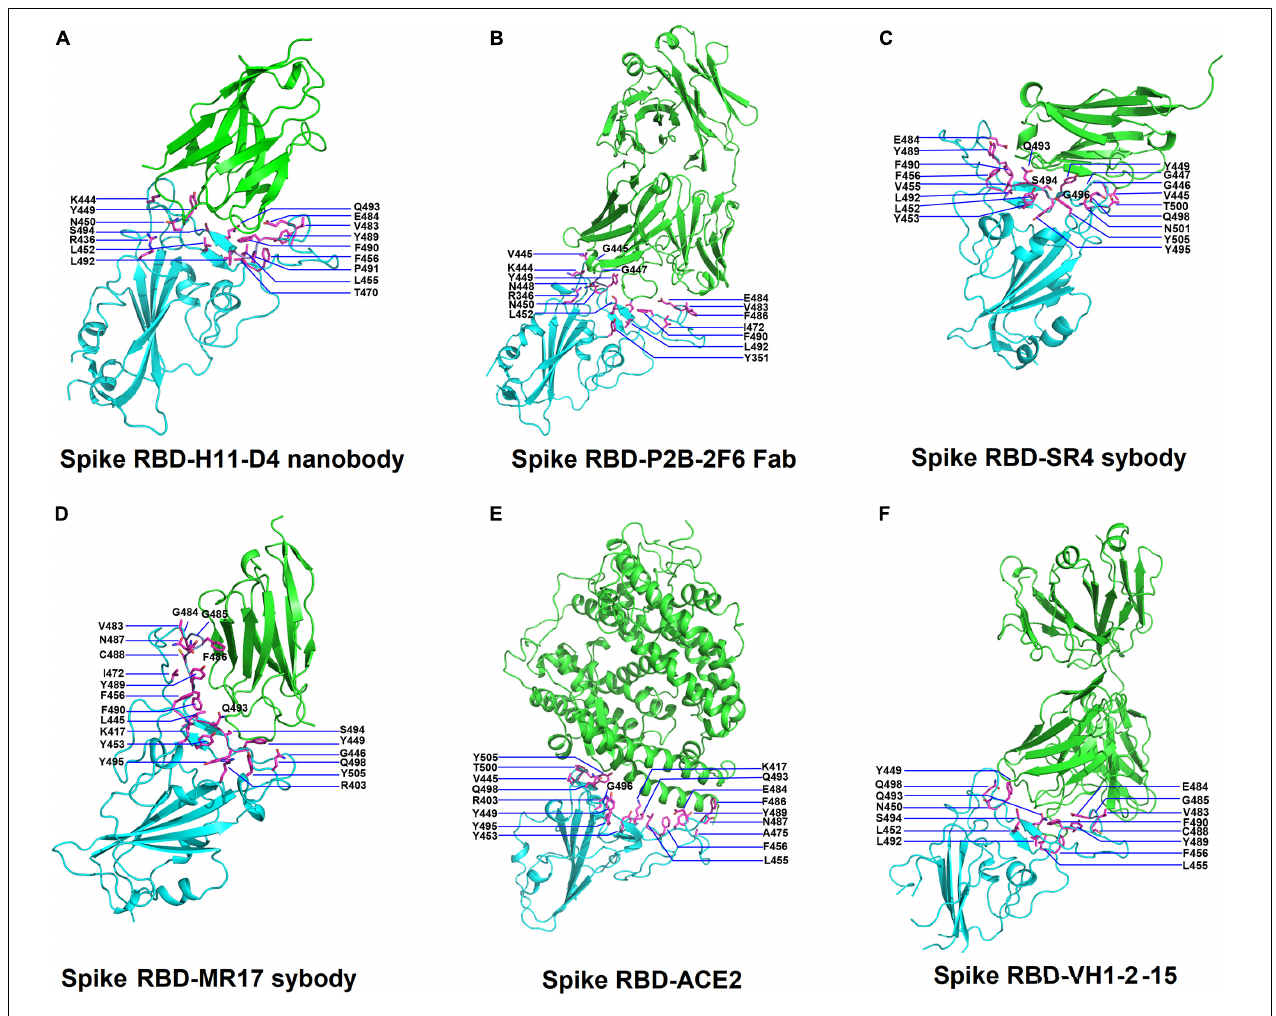
FIGURE 1 | Structures of SARS-Cov-2 receptor-binding domain (RBD) in complex with neutralizing antibodies and angiotensin-converting enzyme 2 (ACE2). (A) The complex structure of RBD with H11-D4 nanobody (PDB ID: 6YZ5). (B) The complex structure of RBD with P2B-2F6 Fab (PDB ID: 7BWJ). (C) The complex structure of RBD with SR4 sybody (PDB ID: 7C8V). (D) The complex structure of RBD with MR17 sybody (PDB ID: 7C8W). (E) The complex structure of RBD with ACE2 (PDB ID: 6M0J). (F) The complex structure of RBD with the VH1-2-15 nanobody (PDB ID: 7L5B). In all panels, the protein structures are shown in ribbons and colored in cyan (RBD) and green (antibodies) with the interactive residues (side chains) presented in sticks